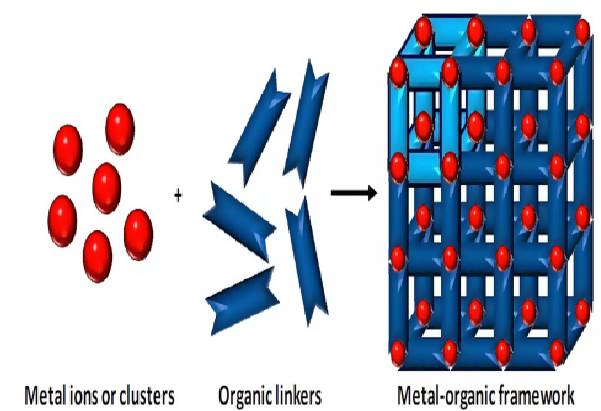
Figure 3. Metal-organic frameworks (MOFs) synthesis by mixing clusters and metal ions with organic linkers for the production of a cross-linked network. Reproduced from MDPI [60].